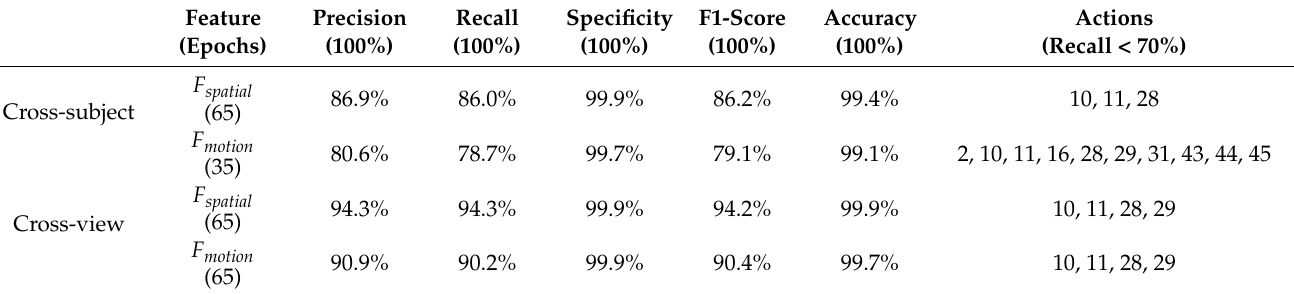
Table 6. The results with the DAG transfer.